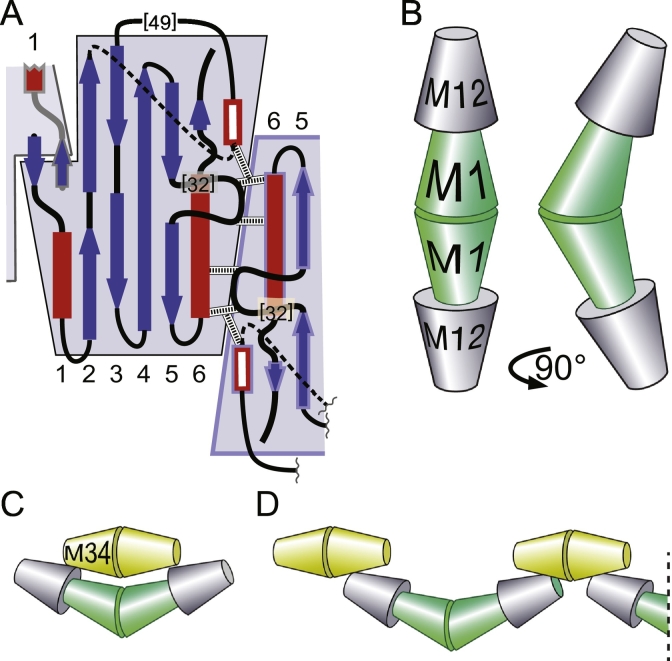
Multimerisation of SMP domains in ERMES. A: Mdm12 can exhibit a second interface for self-interaction. In addition to head-to-head dimerisation (as in Fig. 2E) there is a tail-to-tail self-interaction [32]. Here the helix in element 6 of one monomer forms contacts (white “ladders”) with residues in both the inserted loops of a second monomer (highlighted in light blue); B: Heterotetramers of Mdm12 (grey) and Mmm1 (green) form an extended structure with a central bend of 45°; redrawn from single particle EM visualisations by AhYoung et al. [41]. C and D: Possible hexameric (C) and octameric (D) assemblies of Mdm12, Mmm1 and Mdm34 [41]. Mdm34 (yellow) may homodimerise through interactions of its N-terminal β-sheet, highly similar to that of Mdm12. In addition, it appears to bind Mdm12, which in turn binds Mmm1. Both these interactions are not head-to-head, and they have not yet been studied, though they would allow higher order chains to form.